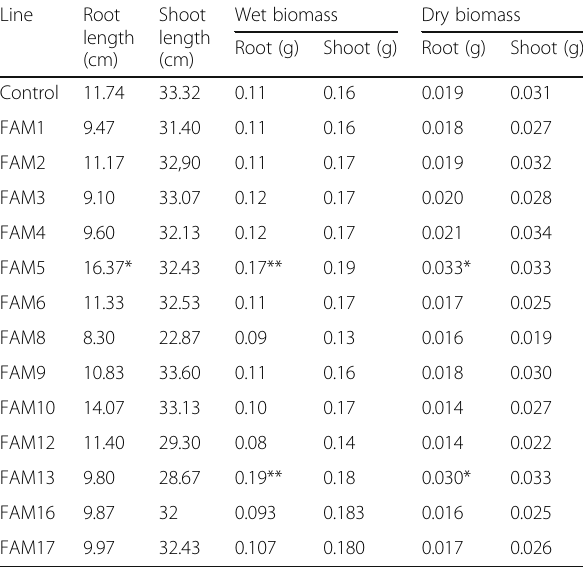
Table 1 Root and shoot characters of control and transgenic rice plants in MS medium containing 1/16 concentration of